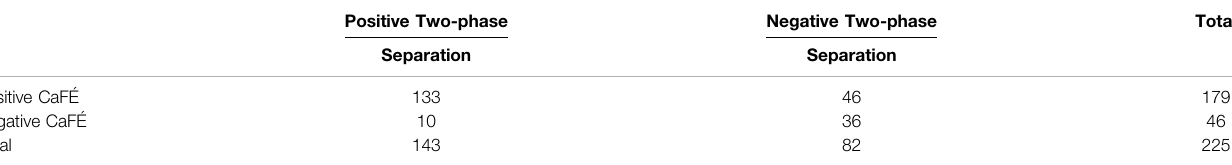
TABLE 3 | Comparison between the two-phase separation method and concentration and fi ltration elution (CaFÉ) method, for the isolation of non-polio enterovirus during theparallelandpilottests:Haïti(December2017 — December2019),Guatemala(November2018 — August2019),Thailand(February2019 —